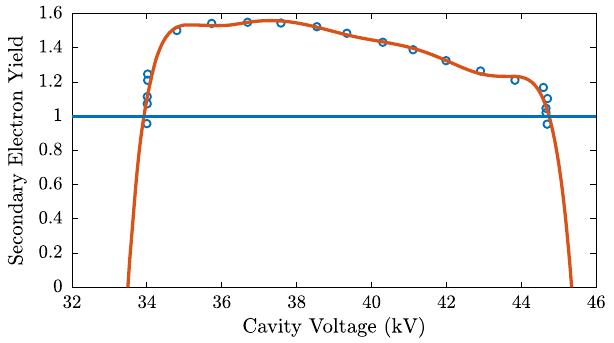
FIG. 17. SEY coefficient of Nb based on the results of the 1st order multipacting simulation using ACE3P.